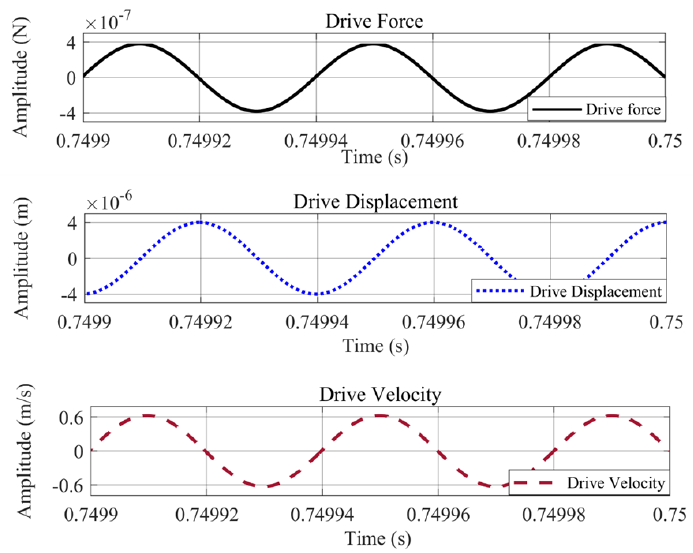
Table 9. Sense-displacement comparison of the proposed single-drive, 3-axis MEMS gyroscope. Parameter Analytical